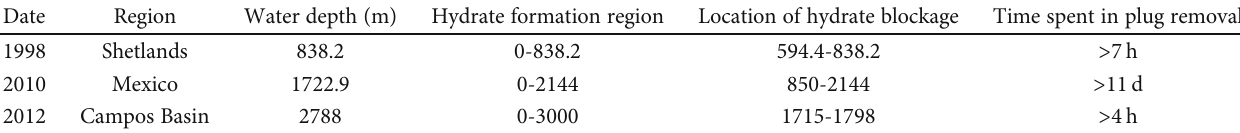
Table 1: Cases of hydrate accidents during deep-water well